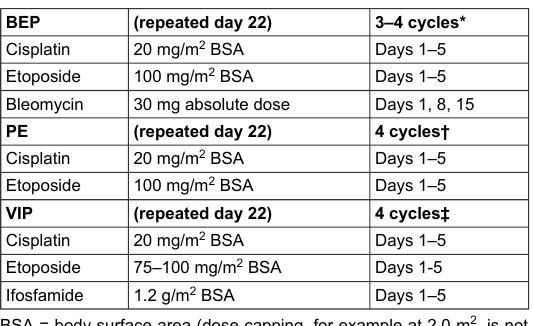
Table 3: First-line treatment